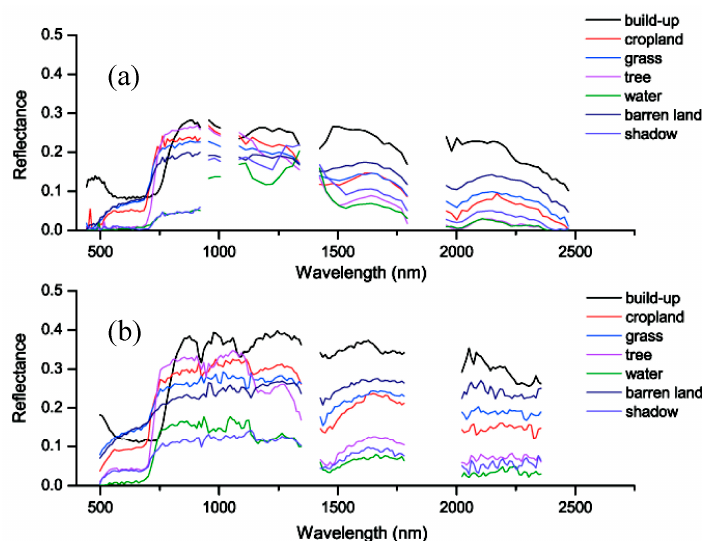
Figure 4. Comparison of different spectra reflectance of land-cover types obtained from TG-1 ( a ) and Hyperion ( b ), from the corresponding represented pure region.